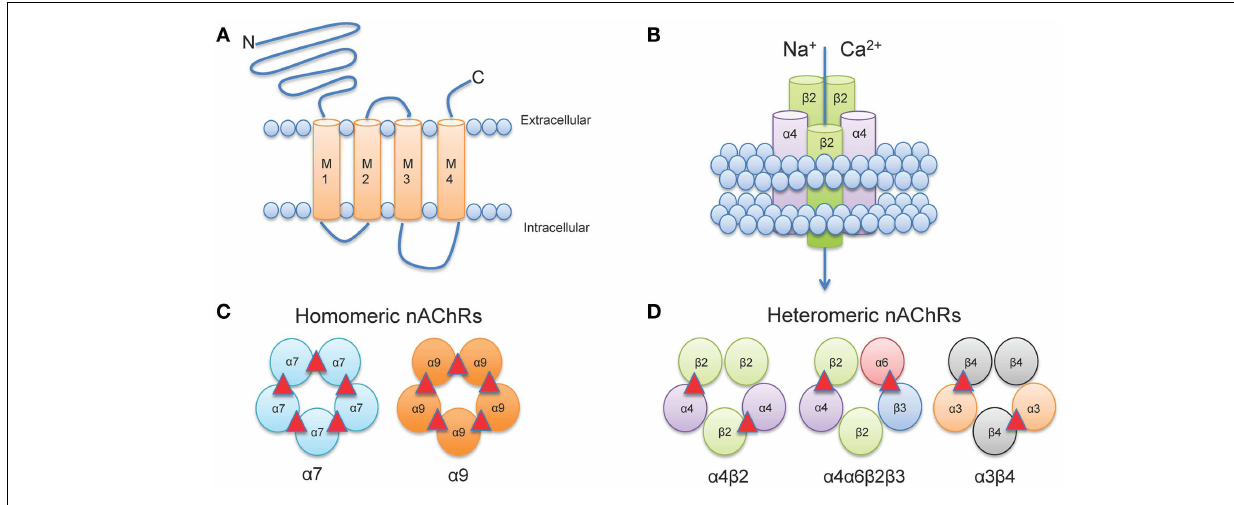
FIGURE 1 | Neuronal nAChR Structure . (A) Membrane topology of a neuronal nAChR subunit. Each nAChR subunit contains four transmembrane domains (M1-M4), an extracellular amino- and carboxy-terminus, and a prominent M3-M4 intracellular loop of variable length. (B) Five subunits coassemble to form a functional subunit. (C) Homomeric receptors consist of α subunits only and usually have